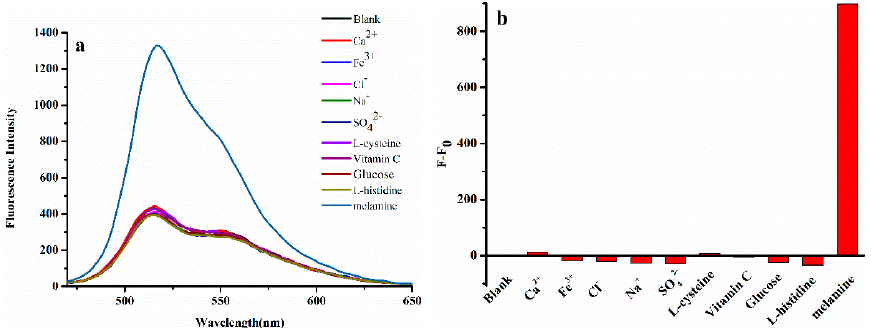
Figure 7. ( a ) Selectivity of the CPNs-AuNPs toward melamine; ( b ) the Bar graph of CPNs-AuNPs selectivity. The concentrations of interferences and melamine were both 2 μ M.